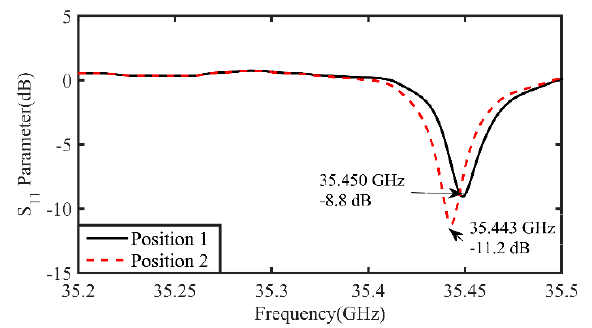
Figure 11. The resonant frequency offset caused by a change in the position of perturbation object. The frequency offset values measured at the center of each cycle are listed in Table 3.